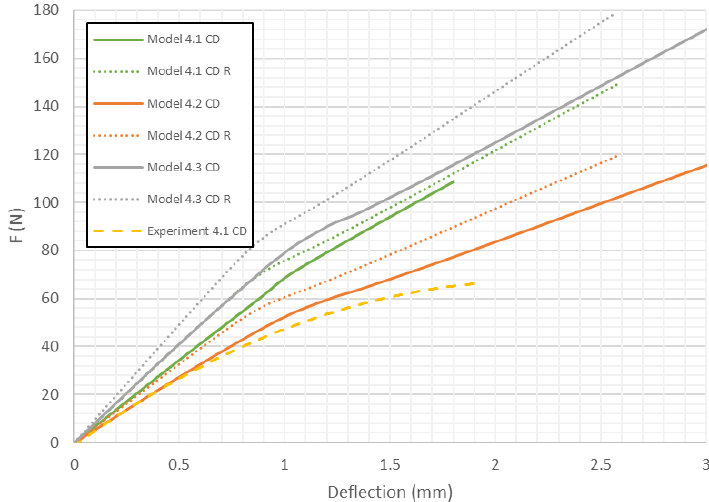
Figure 13. Deflection vs. force for Model 4 in CD.